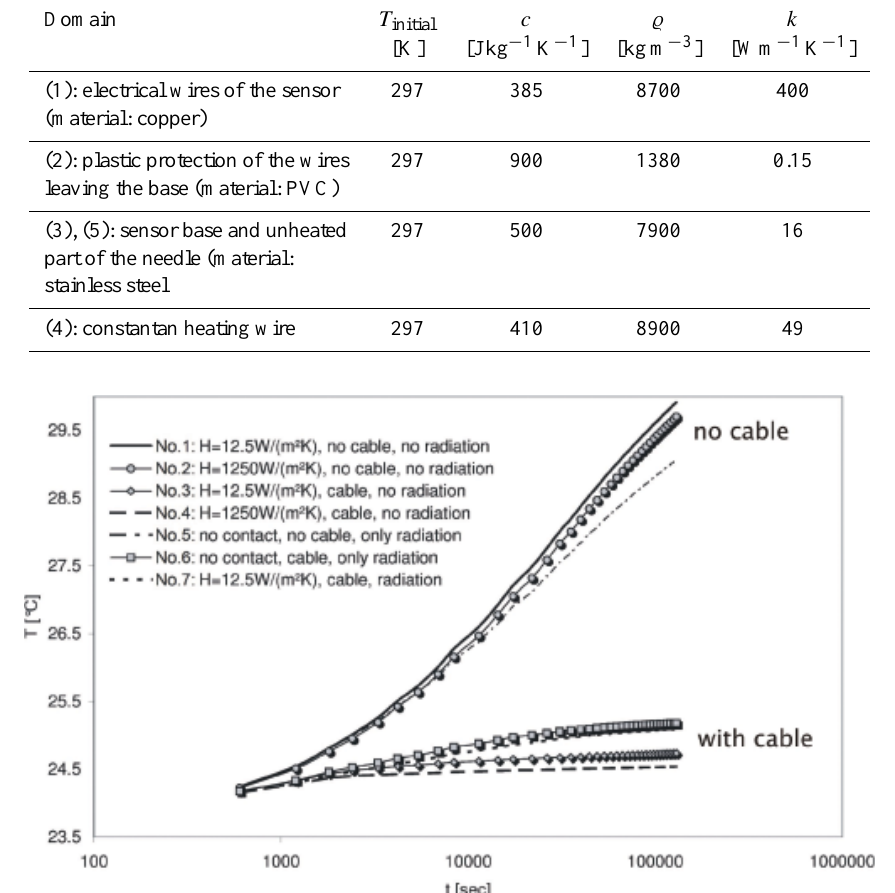
Fig. 17. Temperature response of the LNP03-sensor (short thick needle) at the measurement point due to heating in a very low conductivity sample with λ = 0 . 002Wm − 1 K − 1